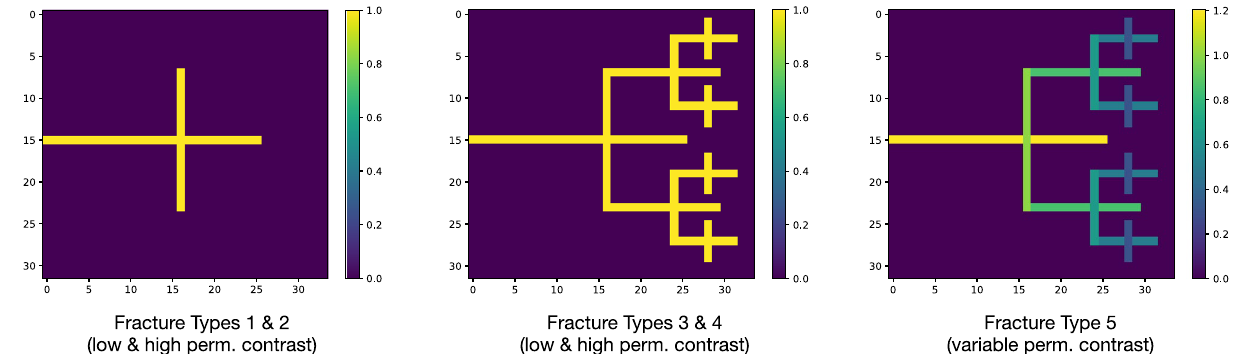
Figure 3. 2D fracture networks under consideration. On the left, Fracture Types 1 & 2 feature a simple -style fracture network (with low & high permeability contrast, respectively). In the middle, Fracture Types 3 & 4 add more fractures via fractal recursion, keeping the permeability constant across fractures (again with low & high permeability contrast, respectively). On the right, Fracture Type 5 gives less permeability to shorter